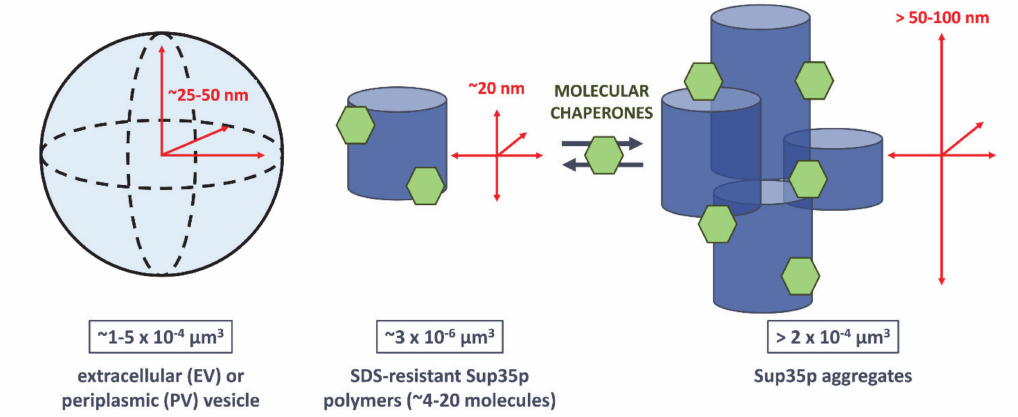
Figure 4. Average volumes of vesicles, detergent-resistant Sup35 polymers and larger Sup35p aggregates. The average volume of extracellular or periplasmic vesicles, considered for simplicity to be perfect spheres, was estimated based on the average diameter (~50–100 nm) of Sup35p-containing vesicles [6,45,47]. The volume of SDS-resistant Sup35p polymers and associated proteins (e.g., molecular chaperones, green hexagons ) was calculated based on the ~20 nm barrel-like structures previously detected by electron microscopy [56]. The volume of the larger Sup35p aggregates was estimated by considering the association of three to four of these barrel-like structures